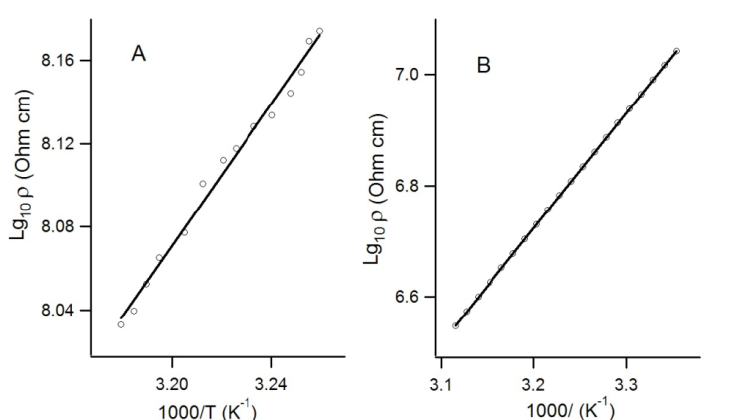
Figure 16. Temperature dependence of the resistance of single crystals of CT